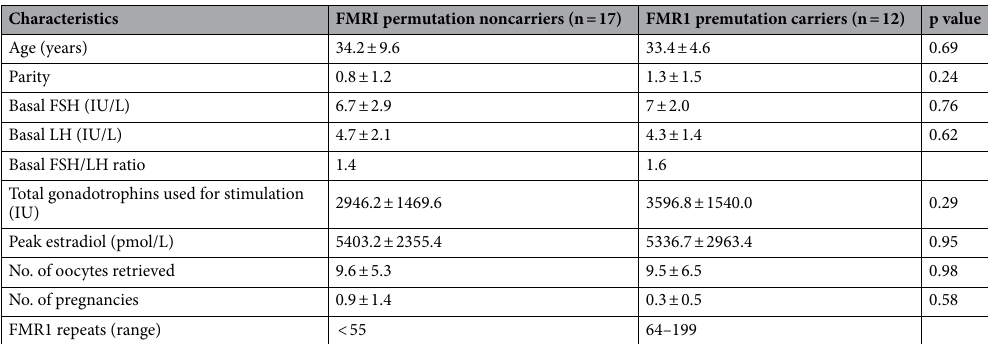
Table 1. Characteristics of FMR 1 premutation carriers and noncarriers. Values given as mean and standard deviation unless otherwise indicated. FSH follicle-stimulating hormone, LH luteinizing hormone.